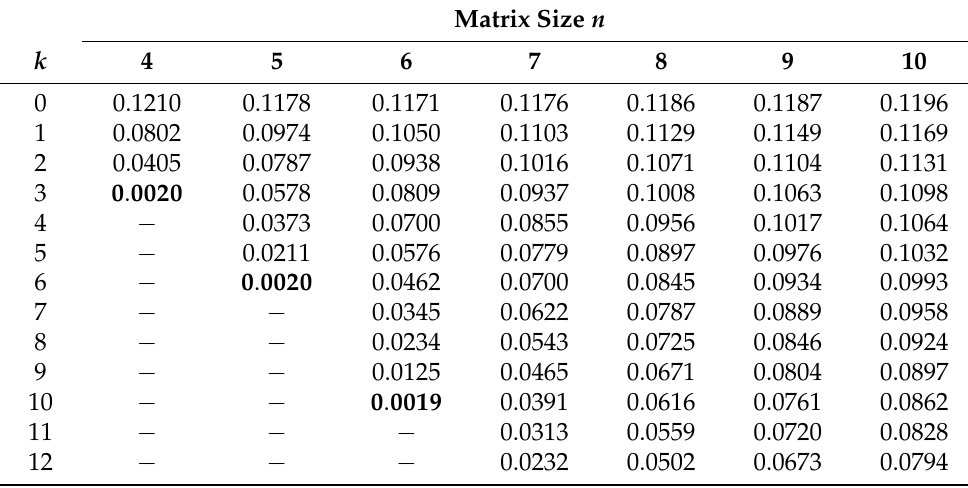
Table 5. Average CR of 10,000 modified consistent matrices using log-normal